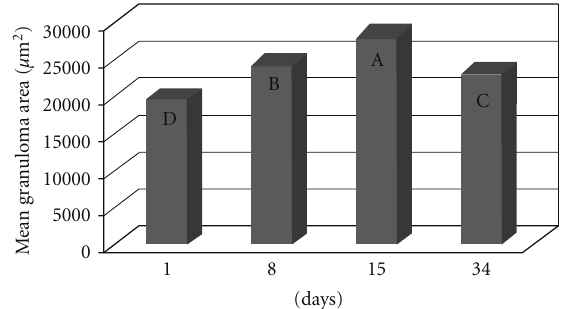
Figure 2: The granuloma area in the lungs of mice that were inoculated with eggs from the S. mansoni BH (Group I) or SJ (Group II) strains and of those that were previously infected with the S. mansoni BH strain and then inoculated 8 weeks later with eggs from the S. mansoni BH (Group III) or SJ (Group IV) strains. The means with di ff erent letters exhibited a significant di ff erence ( α = 0 . 05).